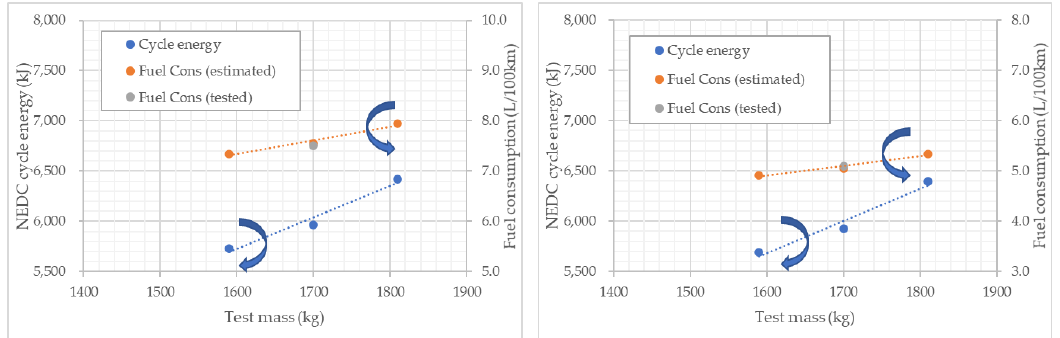
Figure 17. Effect of the test mass on the energy and fuel consumption in NEDC (left/right: gasoline/diesel) .